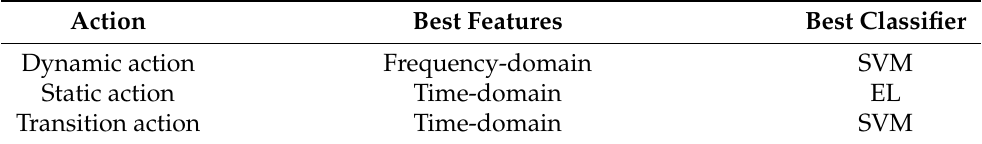
Table 7. Summary of this